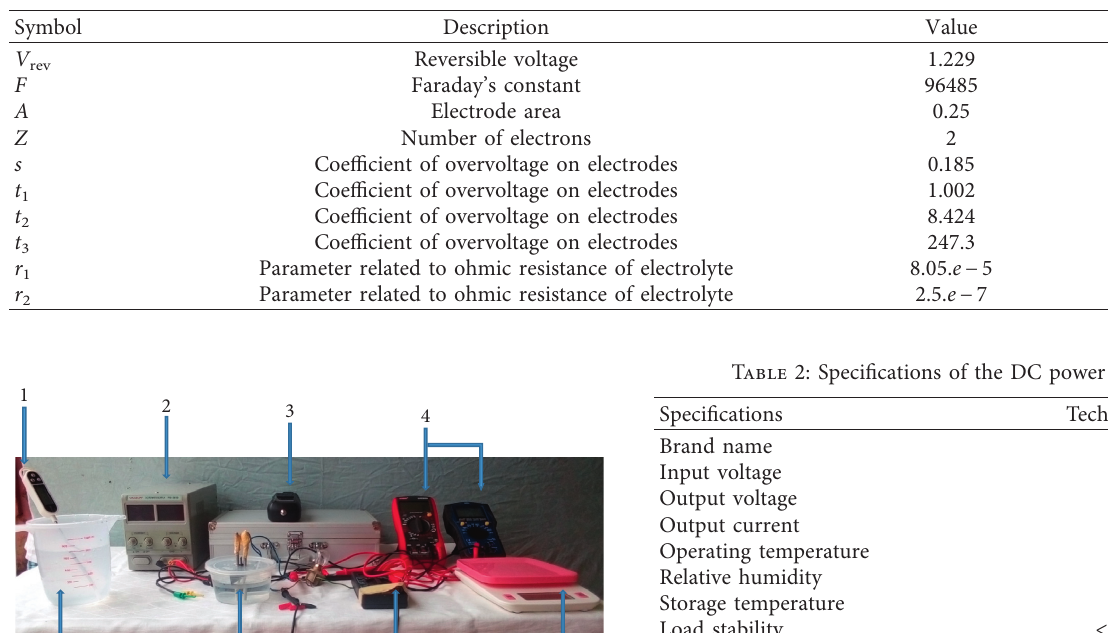
Table 1: Parameters used by Tijani et al.